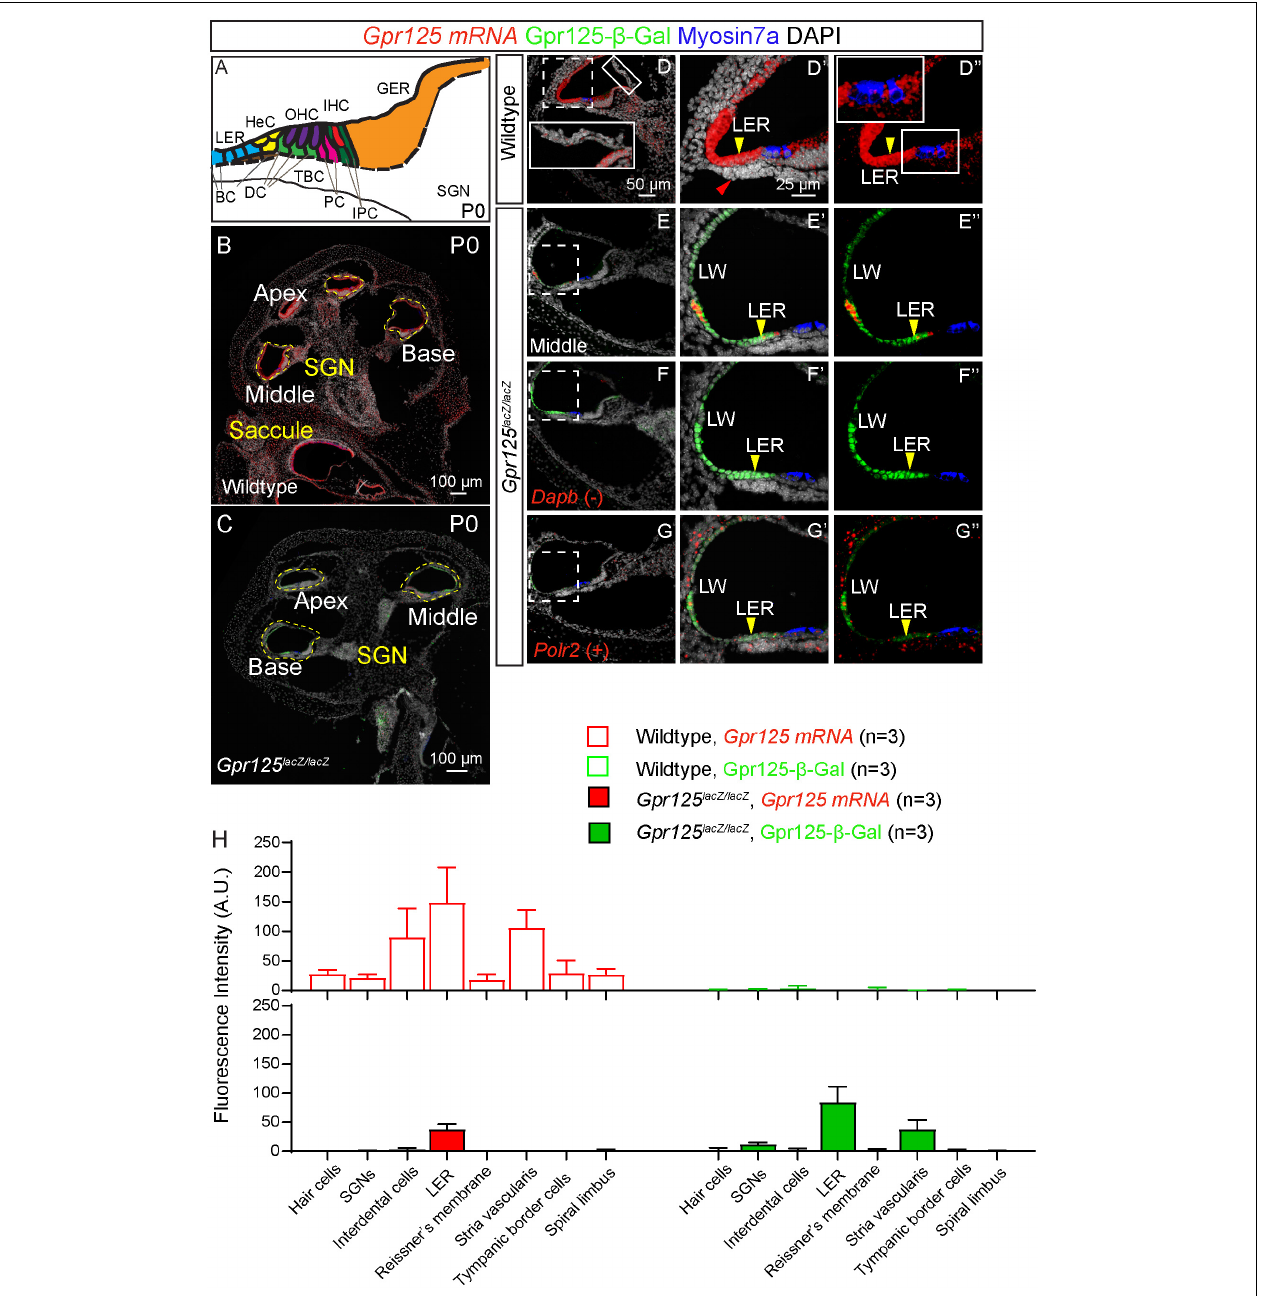
FIGURE 4 | Gpr125 mRNA expression in wild-type and Gpr125 lacZ / lacZ cochleae. (A) Schematic of P0 cochlea showing subtypes of hair cells and supporting cells. BC, Boettcher cells; DC, Deiters’ cells; TBC, tympanic border cells; PC, pillar cells; IPC, inner phalangeal cells; LER, lesser epithelial ridge; HeC, Hensen’s cells; OHC, outer hair cells; IHC, inner hair cells; GER, greater epithelial ridge; SGNs, spiral ganglion neurons. (B,C) Low-magnification image of cryosection demonstrates robust Gpr125 mRNA expression in P0 wild-type cochlea. Gpr125 mRNA expression is low or undetectable in most regions in the Gpr125 lacZ / lacZ cochlea, with the exception of the lateral wall and LER where significant expression remained detectable. (D–D”) High-magnification images of cochlear section showing robust Gpr125 mRNA signals in the wild-type cochlea. Robust Gpr125 mRNA signals were detected at the lateral cochlear wall (LW), outer sulcus, and lesser epithelial ridge, and at lower levels in the organ of Corti, Reissner’s membrane, tympanic border cells (red arrow), spiral limbus, and greater epithelial ridge. No Gpr125- β -Gal-positive cells were detected in the wild-type cochlea. (E–E”) Relative to the wild-type cochlea, Gpr125 mRNA signal is dramatically lower in the Gpr125 lacZ / lacZ cochlea. (F–F”) Labeling for Dihydrodipicolinate reductase ( Dapb ) is used as a negative control. (G–G”) Labeling for RNA polymerase II ( Polr2 ) is used as a positive control. (H) Fluorescence intensity of Gpr125 mRNA and Gpr125- β -Gal protein in cell types of interest. Gpr125 mRNA signal is the highest in the LER in wild-type cochleae. Similarly, immunolabeling for β -Gal protein expression is the strongest in the LER in Gpr125 lacZ / lacZ cochleae. The fluorescence of Gpr125 mRNA correlated to β -Gal ( R 2 = 0.82, p < 0.01, Pearson’s correlation). Data are presented as mean ± SD.